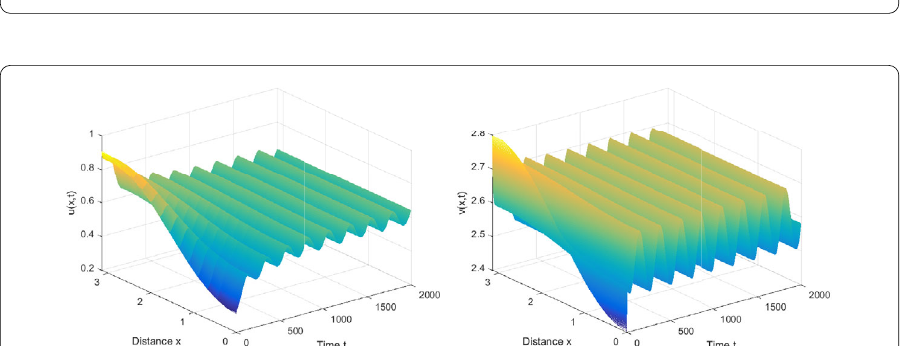
Figure 7 When ( μ 1 , μ 2 ) = (0.001,0.00002) lies in region ⑤ , system (23) has an unstable constant steady state E 4 (0.6115,2.6044) and a stable spatially homogeneous periodic solution, where u ( x ,0) = 0.6115 – 0.1cos x , v ( x ,0) = 2.6044 – 0.1cos x . The simulate time is from 0 to 100 in ( a ) and ( b ) and the simulate time is from 1000 to 3000 in ( c ) and ( d